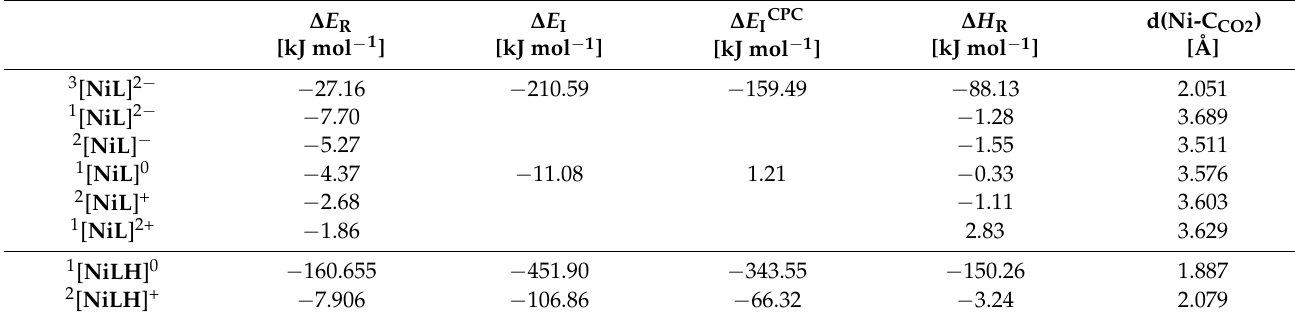
Table 1. The reaction and interaction energies/enthalpies of the studied [ NiL ] and [ NiLH ] complexes with CO 2 in different spin states, including Ni–C CO2 bond